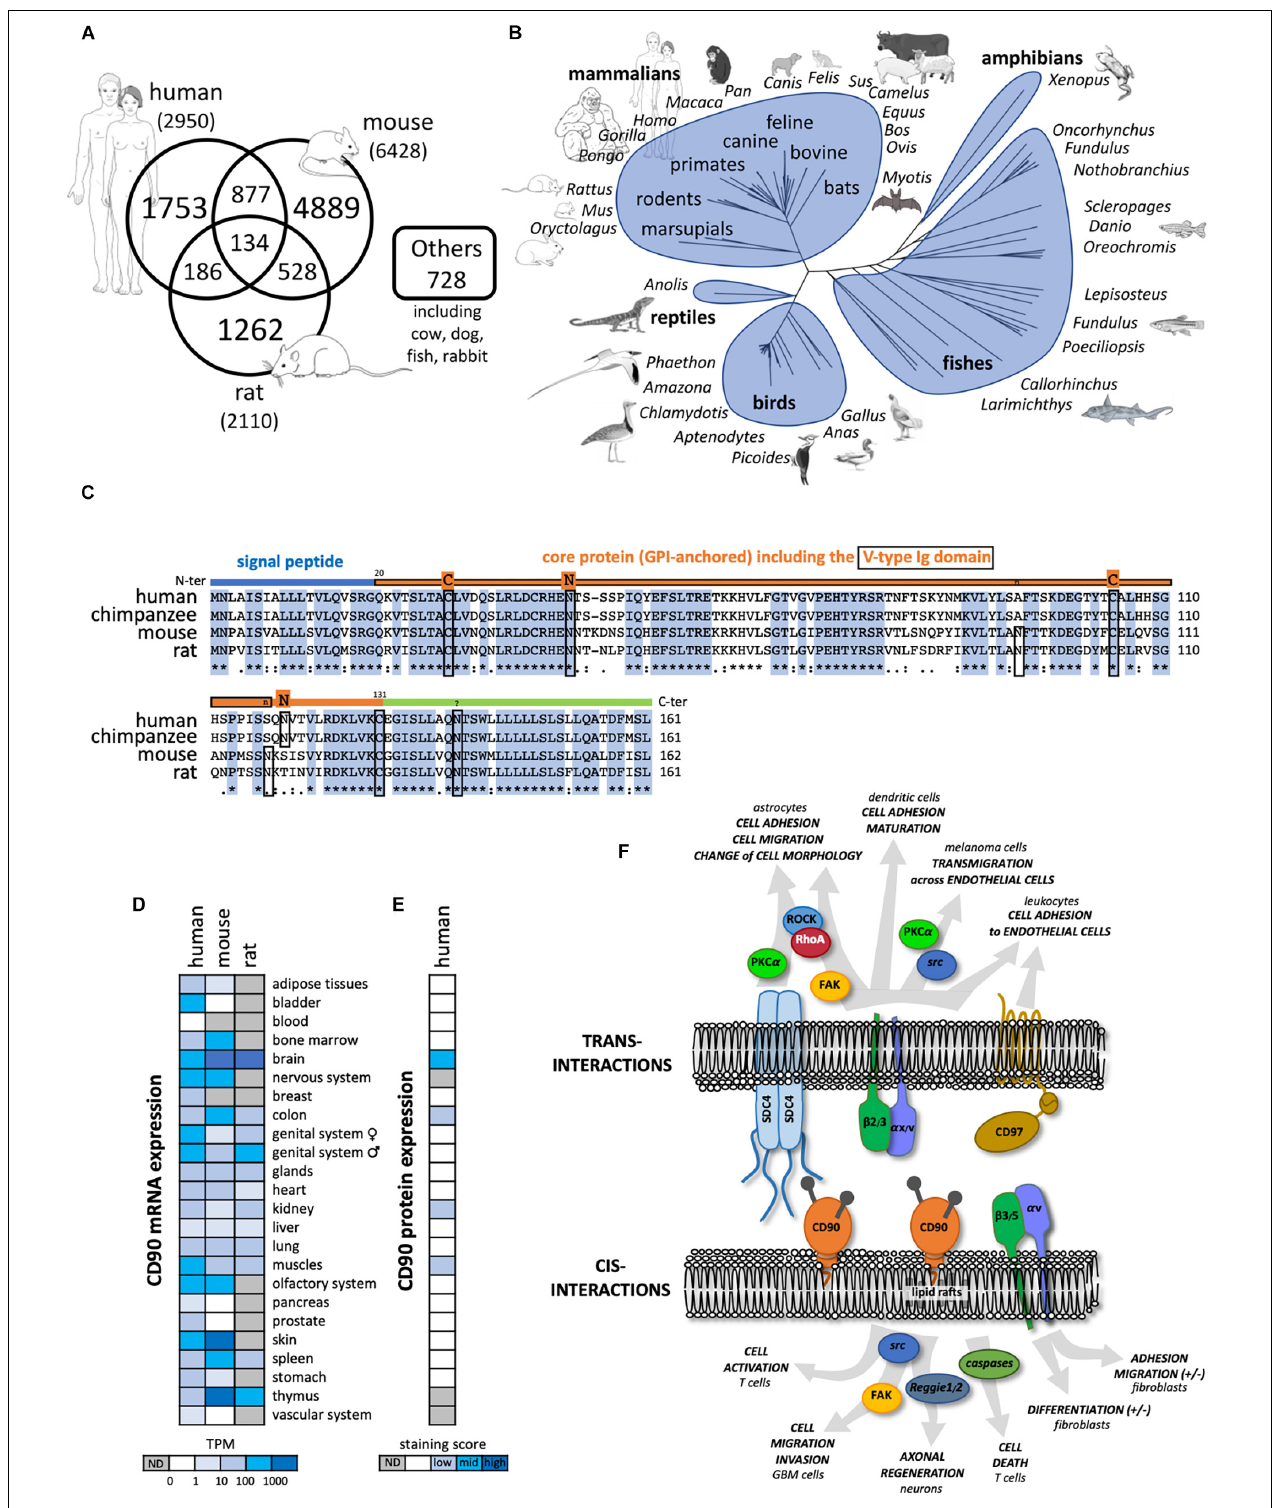
FIGURE 1 | General features of CD90 molecule. (A) Number of publications until November 2018 referring to CD90 according to the different species collected in Pubmed (https://www.ncbi.nlm.nih.gov/pubmed). (B) Tree representing the evolution of CD90 proteins among vertebrates. (C) The CD90 protein sequences from human, chimpanzee, mouse, and rat were aligned showing a highly conserved domains. The main features of the protein including the signal peptide (blue line), the